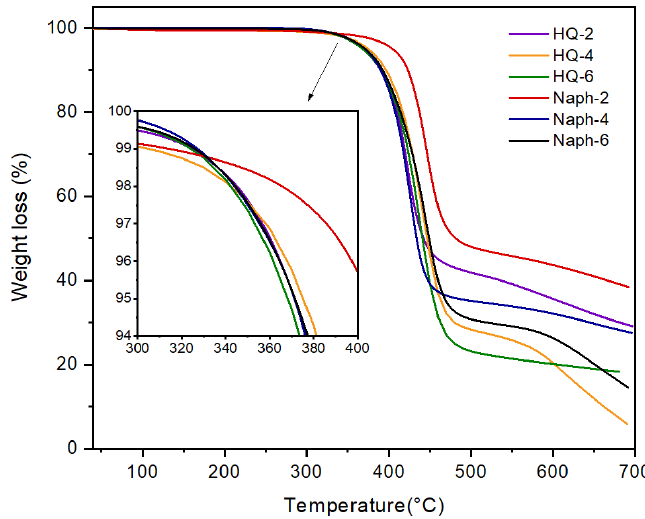
Figure 4. Thermogravimetric analysis (TGA) thermograms of HQ‐ and Naph‐TLCPs.